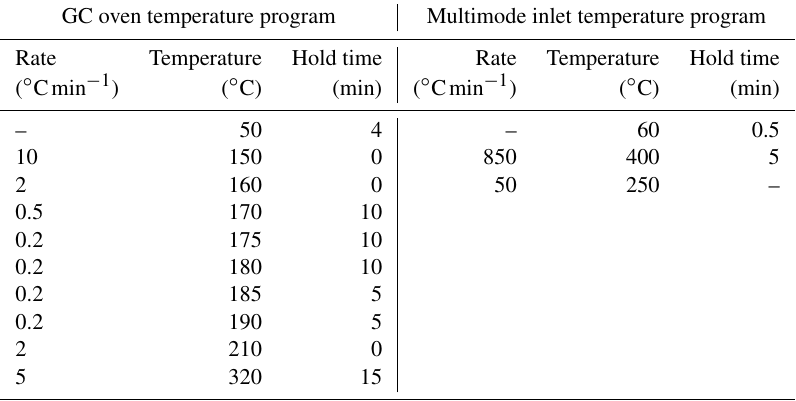
Table B1. GC oven and multimode inlet temperature programs for PLFA measurements.